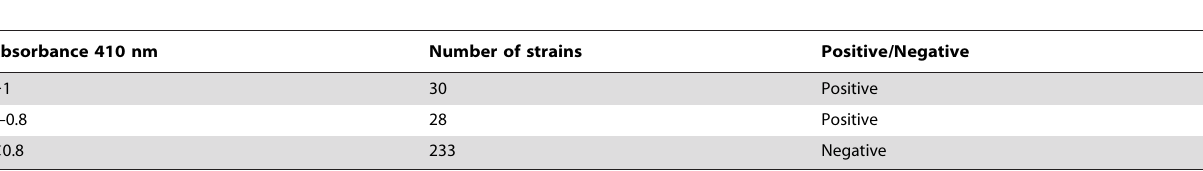
Table 3. Classification and selection of bacteria showing transesterification activity according to the para -nitrophenylpalmitate test.